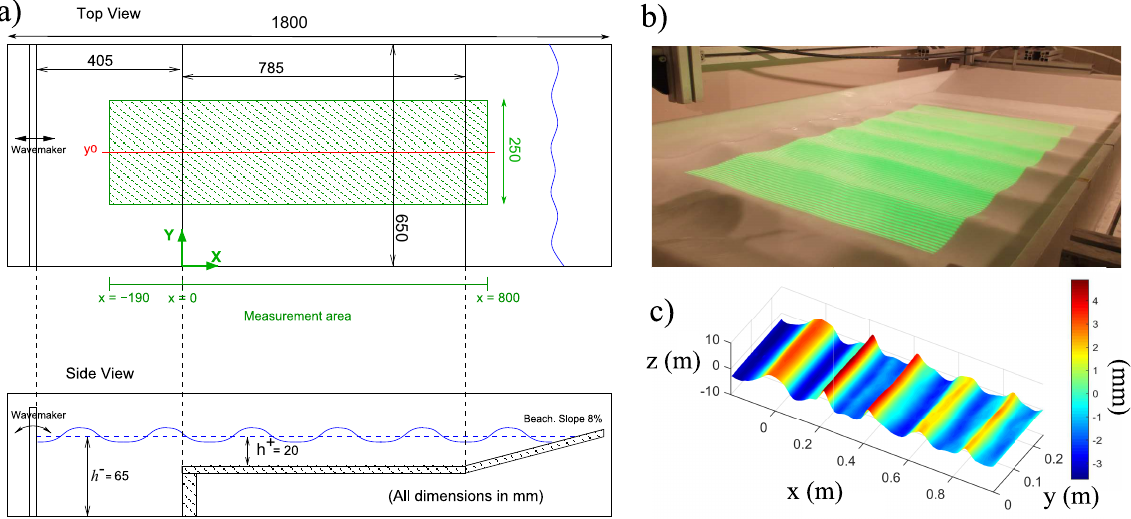
Figure 10. Experimental set-up. ( a ) Sketch of the top and side views of the experimental tank. The measurement area is highlighted in green. ( b ) Experimental tank with the sinusoidal pattern of the FTP technique projected onto the diffusive surface. ( c ) Typical experimentally measured field of a